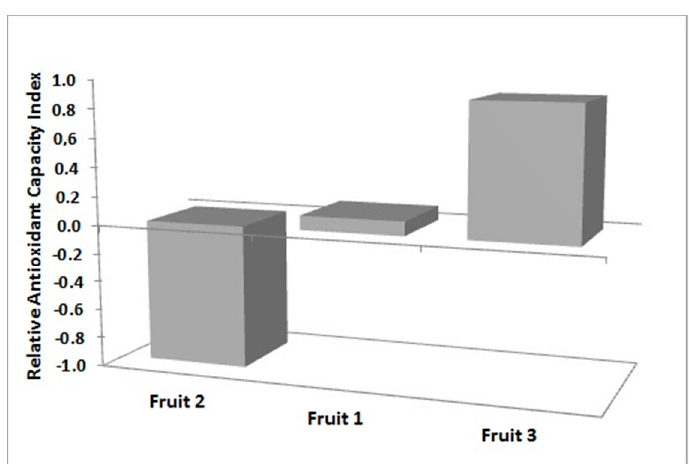
Figure 1. Relative antioxidant capacity index (RACI) values obtained comparing TPC, DPPH, FRAP, BCB, NO, and SO results. DPPH: 2,2-diphenyl-1-picrylhydrazyl; FRAP: ferric reducing antioxidant power; BCB: β -carotene bleaching assay; TPC: total polyphenolic content; RACI: relative